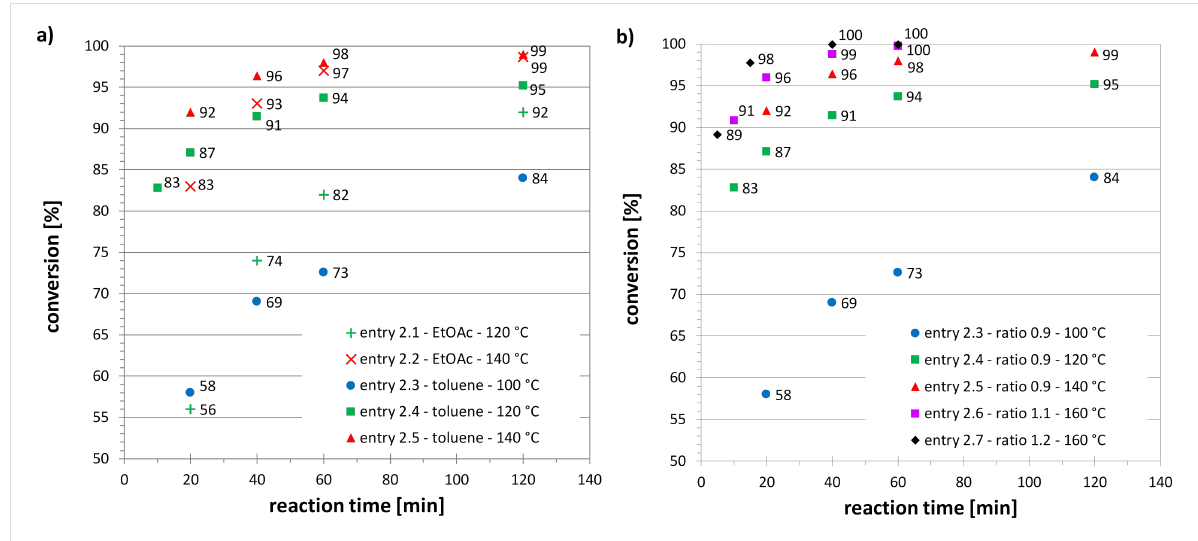
Figure 1: Kinetic studies of the Diels–Alder reaction between myrcene ( 1 ) and acrylic acid ( 2b ); a) for different solvents and temperatures, ratio of myrcene to acrylic acid: 0.9; b) for different starting material ratios and temperatures, solvent: toluene.